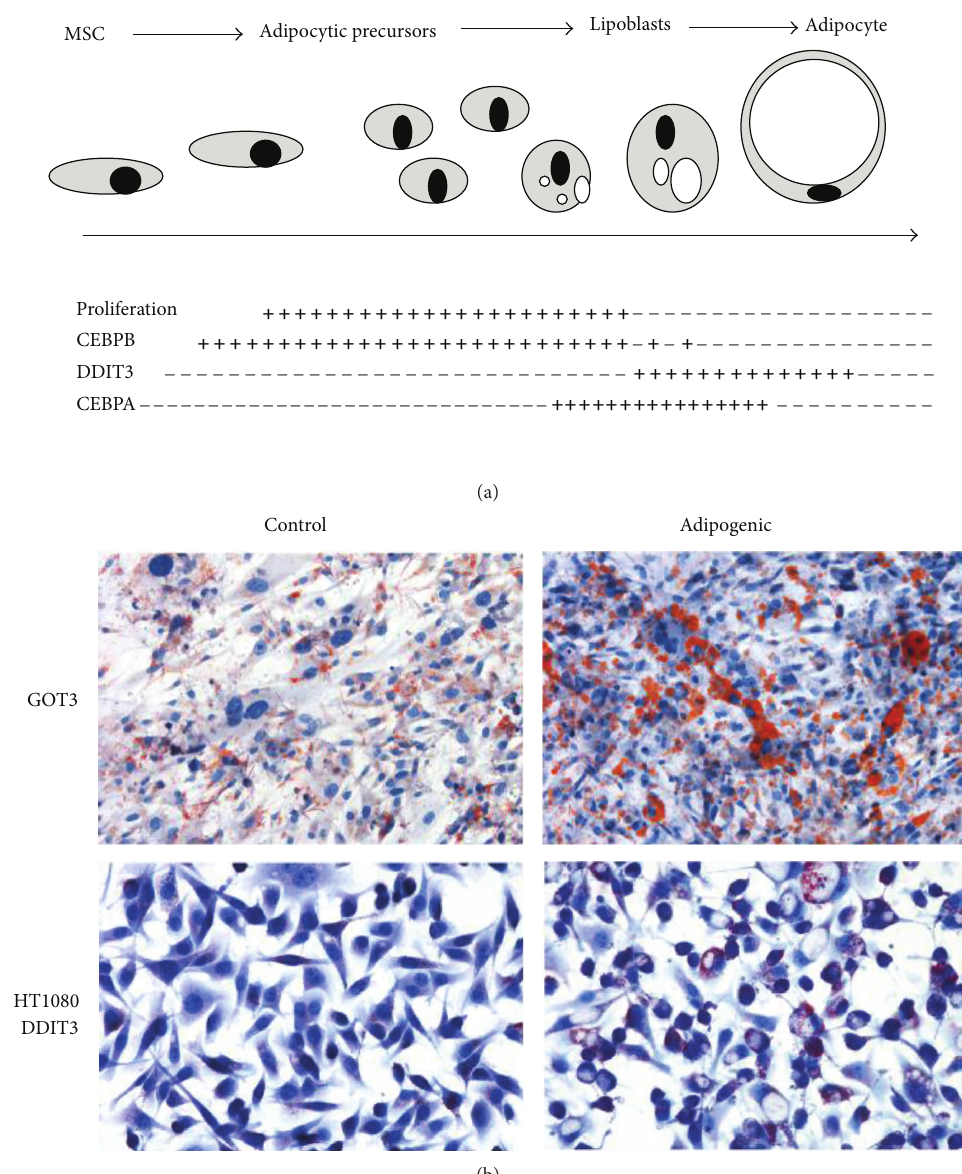
Figure 2: Adipocytic differentiation. (a) Schematic presentation of CEBPB, CEBPA, and DDIT3 expression in adipocyte differentiation. (b) Lipoblast formation and accumulation of lipids in GOT3 WDLS/DDLS derived cell line (top panels) and DDIT3 transfected HT1080 fibrosarcoma cell line (bottom panels) cultured in control or adipogenic medium. Oil Red O staining shows lipids in